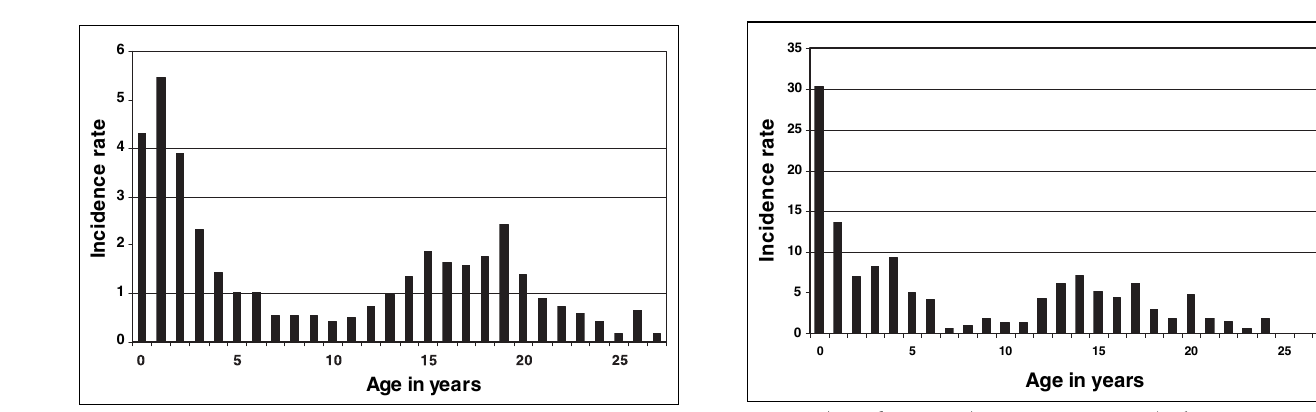
Figure 1) Incidence rate (per 100,000 per year) of invasive meningo- coccal disease in Canada,* according to age, from 1995 to 1998. Data from Health Canada, written communication